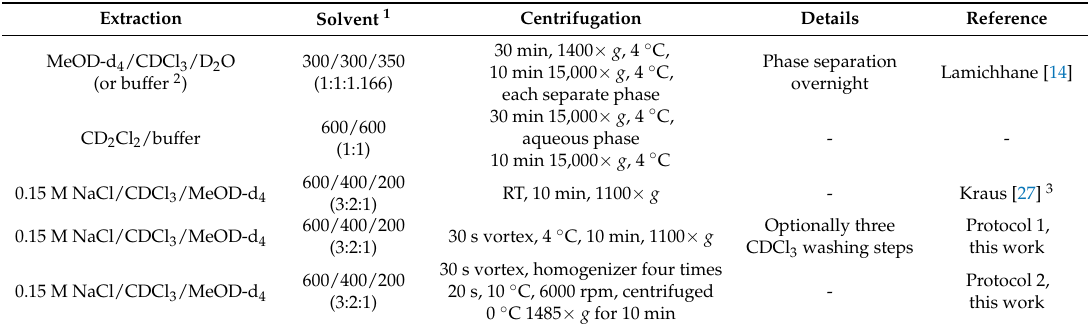
Table 2. Summary of the two phase extraction protocols used for the homogenized mice